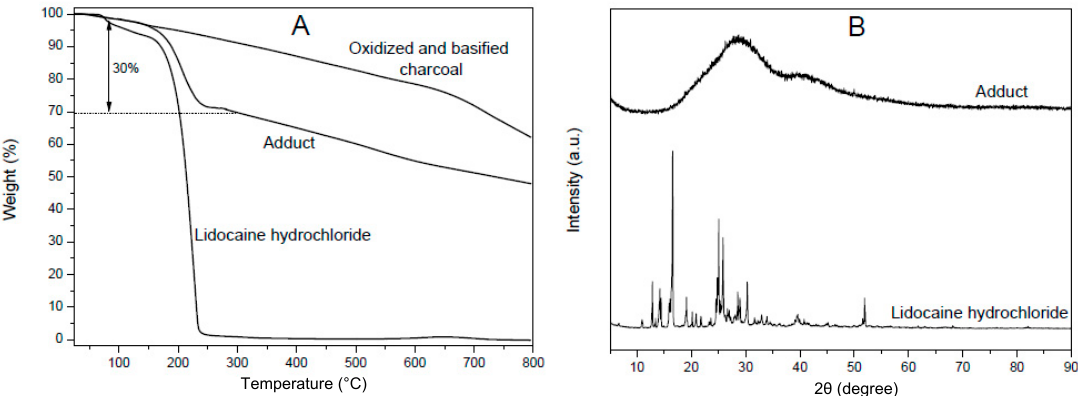
Figure 3. TGA scans ( A ) and WAXD patterns ( B ) of lidocaine hydrochloride and of its adducts with oxidized and basified charcoal (charcoal/lidocaine, 70/30 wt/wt), as prepared by a large excess of lidocaine.